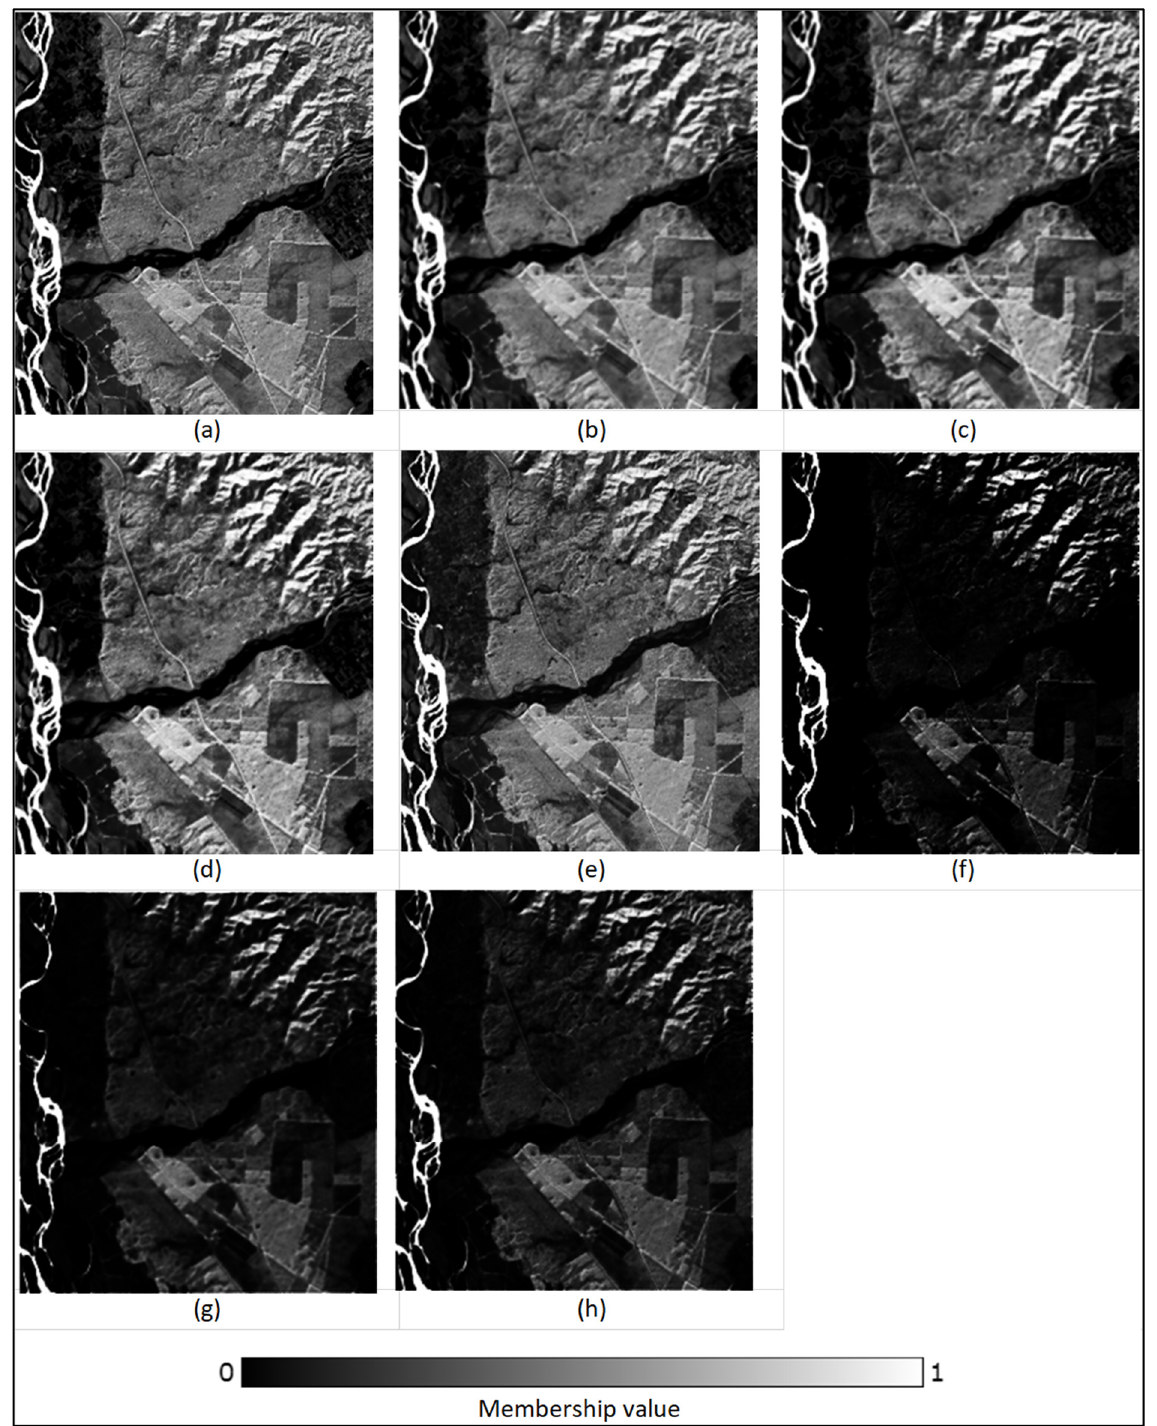
Figure 15. Membership fraction (0–1) for the class ‘Water’ generated by ( a ) FCM, ( b ) FCM-S, ( c ) FLICM, ( d ) ADFLICM, ( e ) PCM, ( f ) PCM-S, ( g ) PLICM, and ( h ) ADPLICM classifiers in the presence of untrained classes.